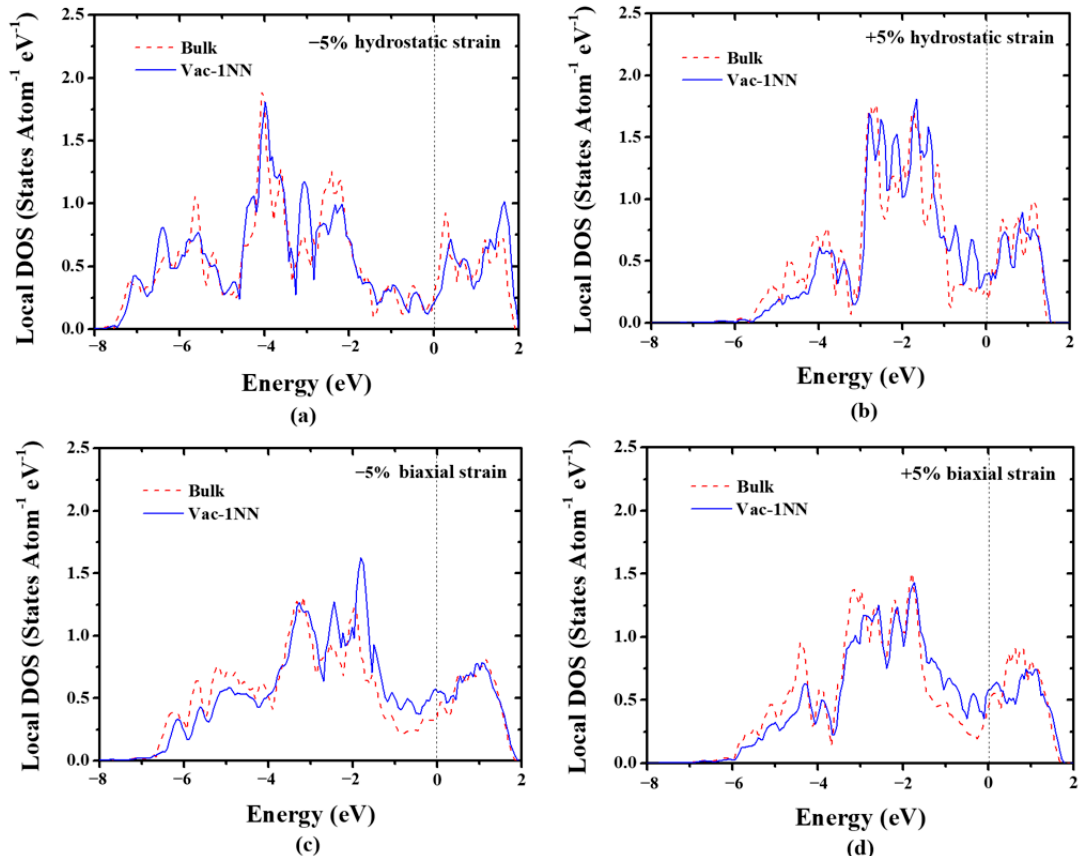
Figure 3. The LDOSs projected on the 5 d orbitals of a bulk W atom and the 1NN W atom surrounding the monovacancy under different strain conditions. ( a ) 5% compressive hydrostatic strain, ( b ) 5% tensile hydrostatic strain, ( c ) 5% compressive biaxial strain, and ( d ) 5% tensile biaxial strain. The Fermi level is denoted by the black dashed line.